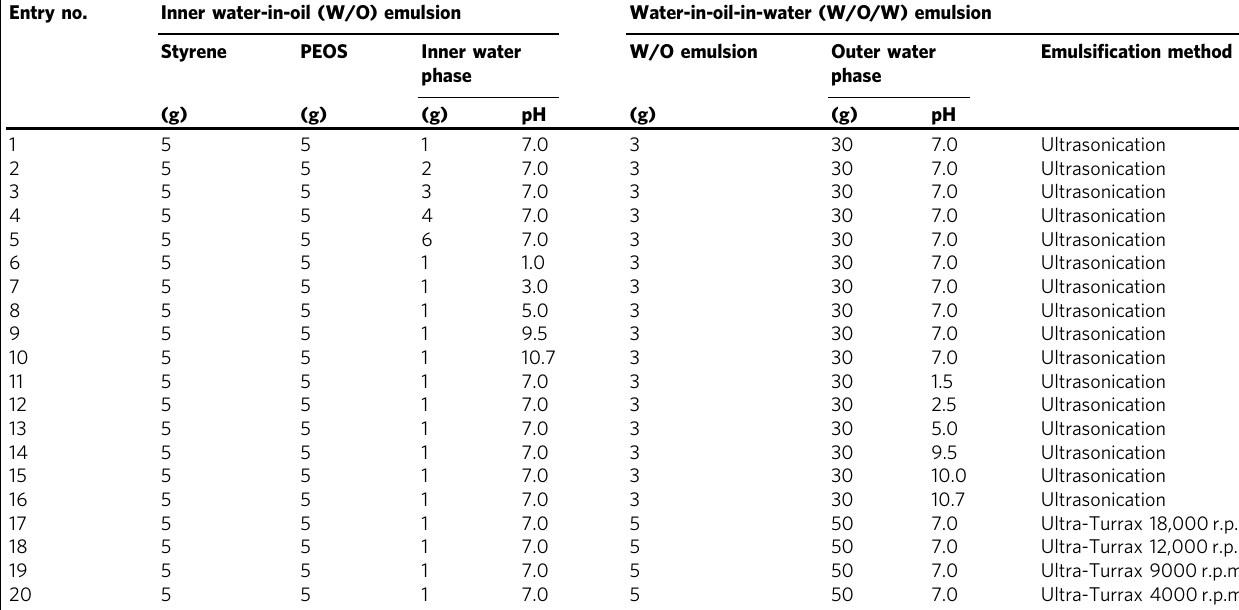
Table 1 Recipes for preparation of water-in-oil-in-water double emulsions Entry no.